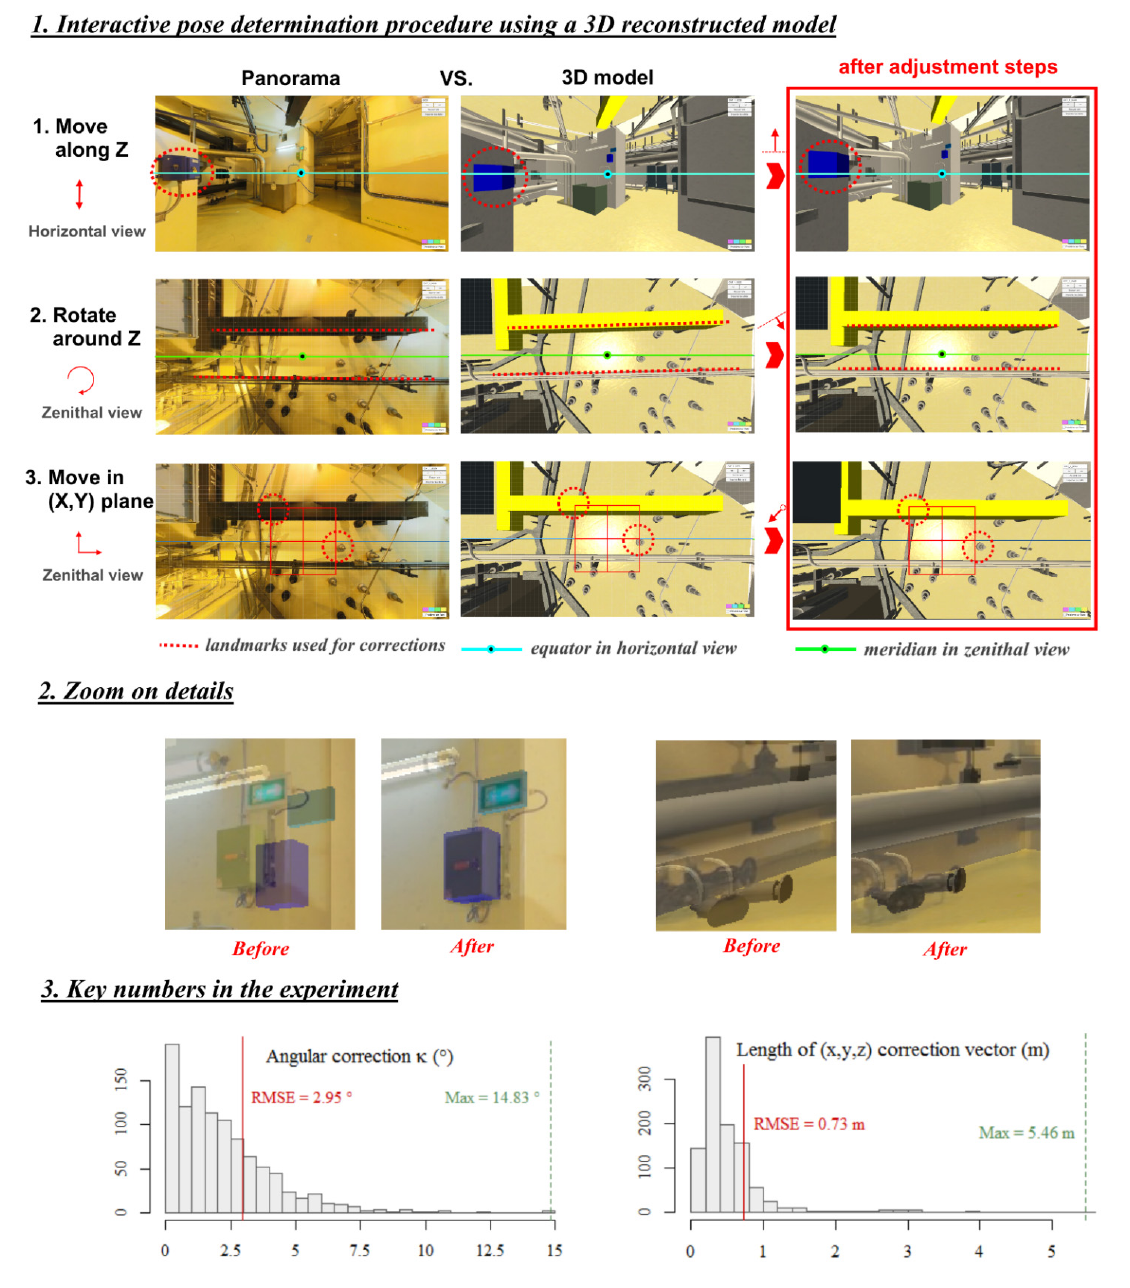
Figure 13. User interface and procedure for fully estimating the pose of panoramic images in reference to a 3D model ( Top ). Equator, meridians and central dots help with the alignment and correction of parameters. Zoom on specific details (before/results) ( Middle ). Key numbers in the corrections using the 3D model (1025 images) ( Bottom ).